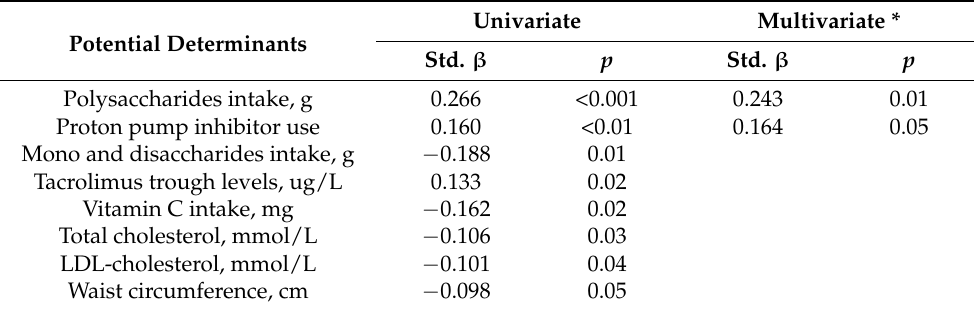
Table 2. Potential determinants of Log 2 exhaled H 2